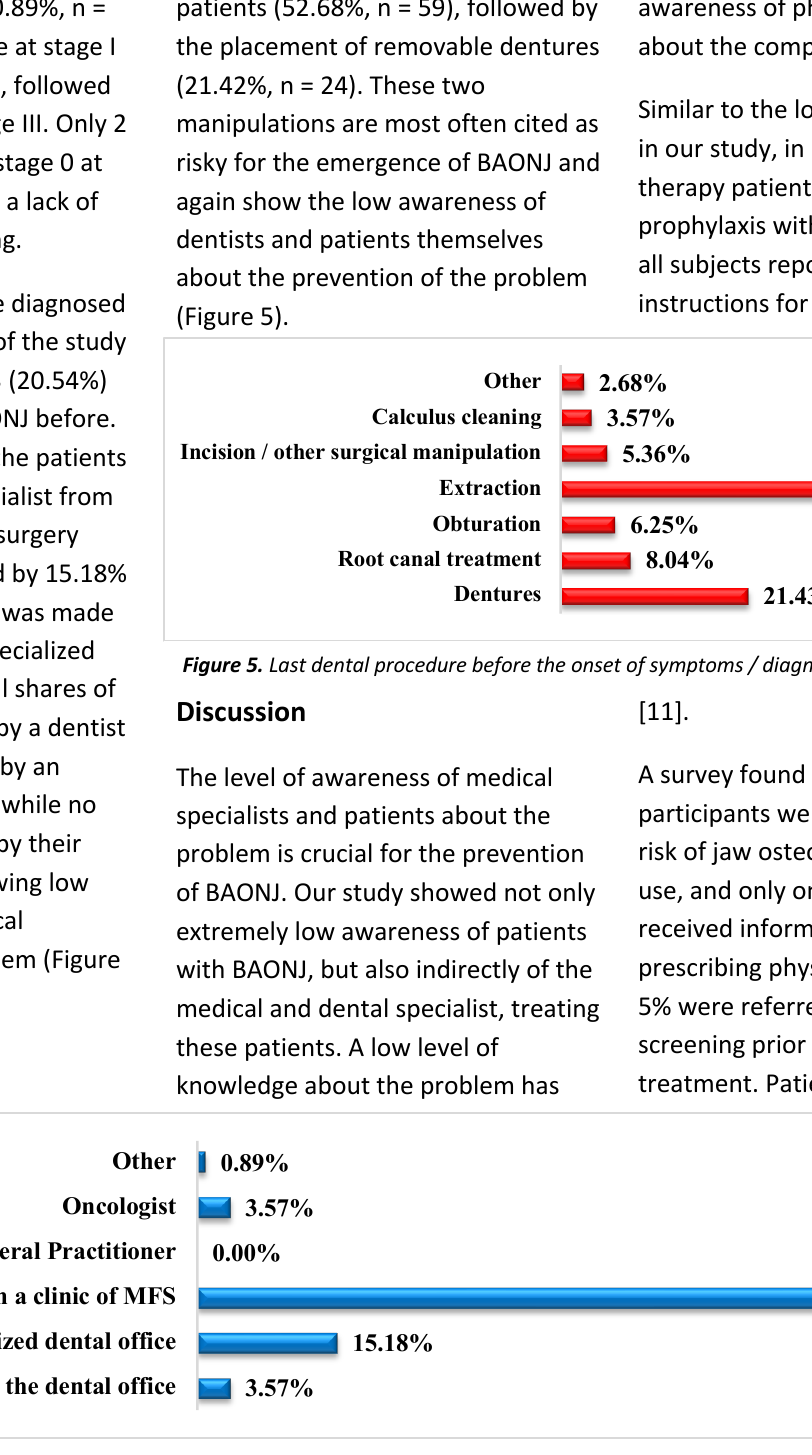
Figure 4. Distribution of physicians, who diagnosed by BAONJ, by their specialty.